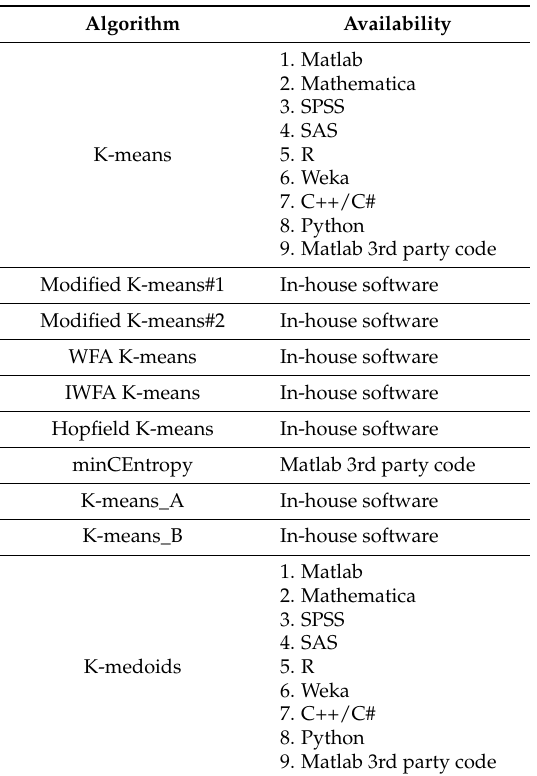
Table 11. Software availability per algorithm